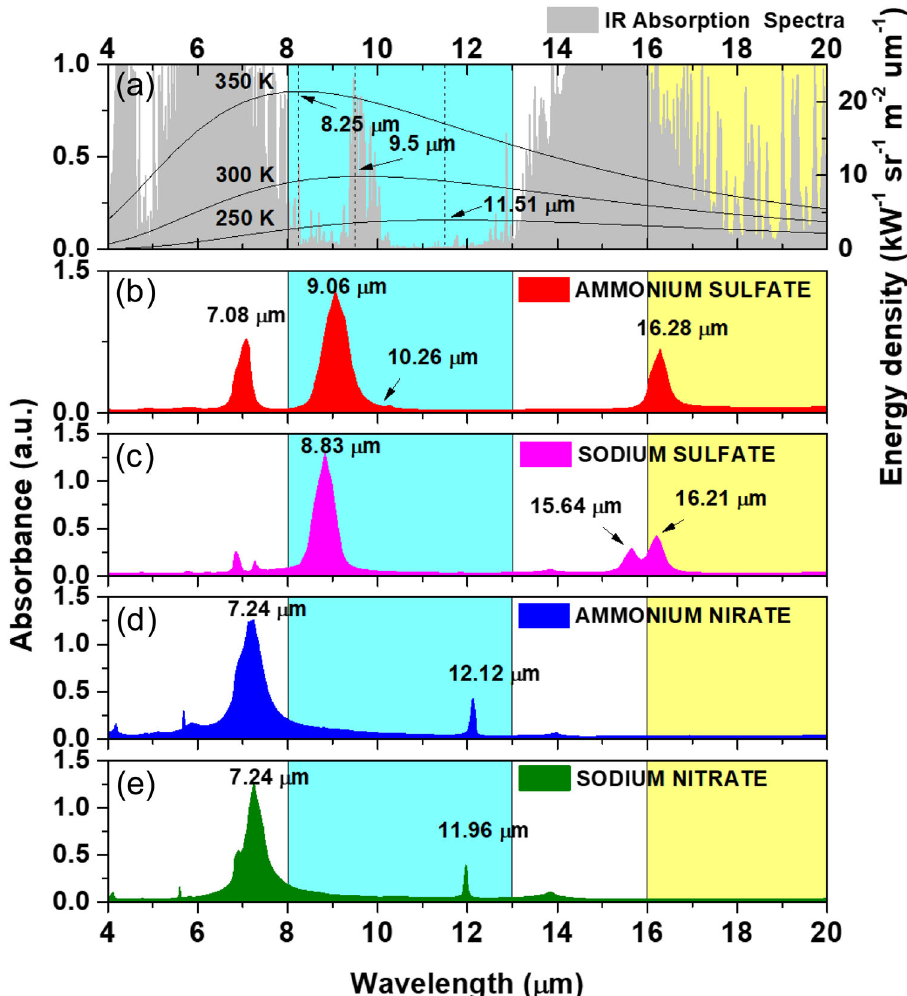
Fig. 1 Atmospheric IR absorption spectra and infrared absorption spectra of sulfate and nitrate. a Black-body emission curves of the Earth at various temperatures (black curves), with atmospheric IR absorption spectra at an air mass of 1.0 (gray area) as a reference. b – e IR absorption spectra of ammonium sulfate (NH 4 ) 2 SO 4 , sodium sulfate (Na 2 SO 4 ), ammonium nitrate (NH 3 NO 3 ), and sodium nitrate (NaNO 3 ) in the wavelength range from 4 to 20 µ m (Recalculated from Sigma Library of FT-IR